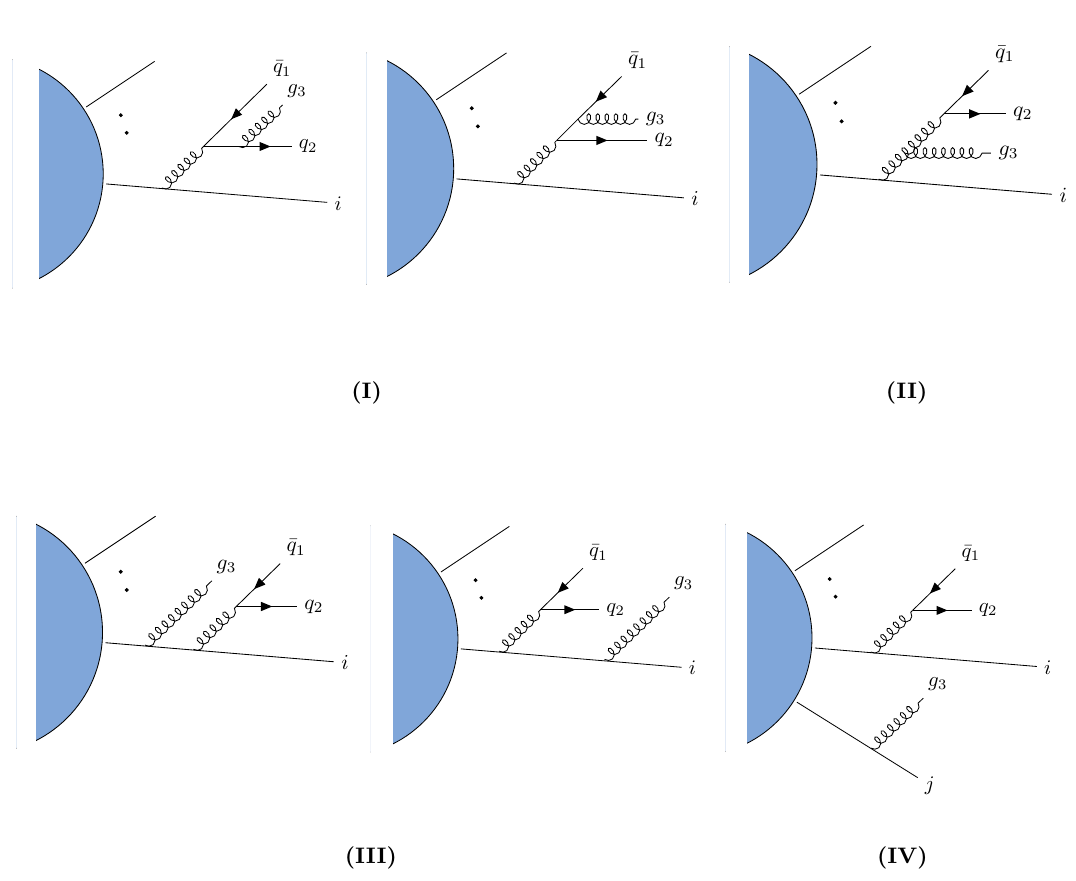
Figure 1. Soft-gluon insertion diagrams for the emission of a soft gluon and q ¯ q